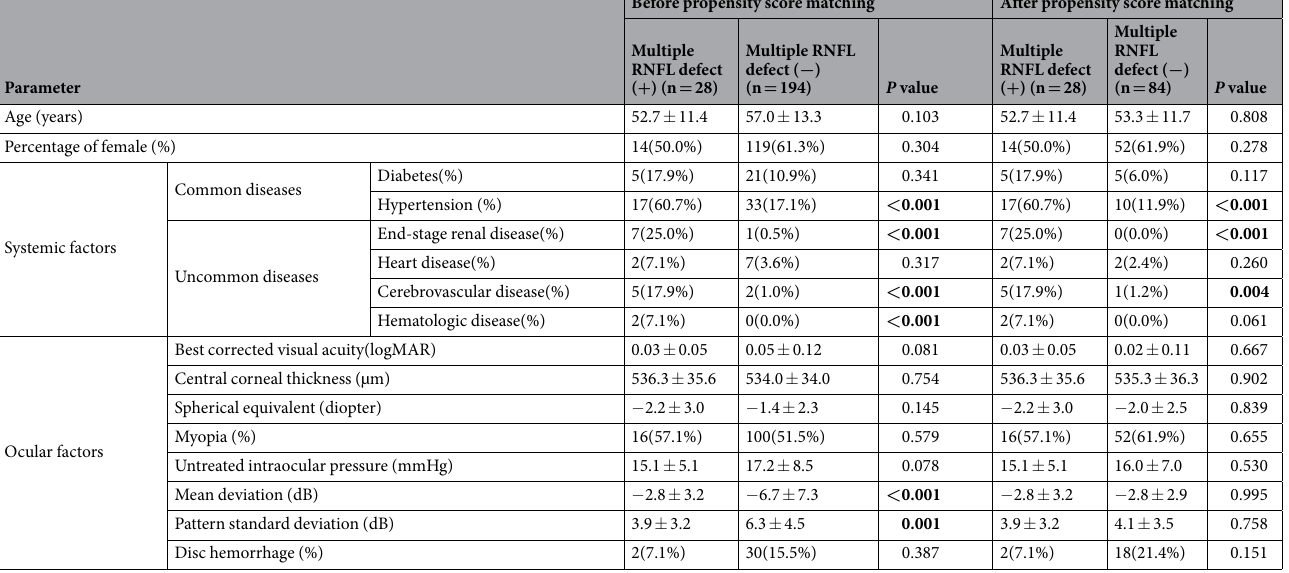
Table 2. Optic disc and retinal never fiber layer parameters, and posterior pole profiles. CDR, cup-to-disc ratio; OCT, optical coherence tomography; PPA, parapapillary atrophy. * Statistically significant differences between two groups ( P < 0.05) by Student’s t-test are indicated in